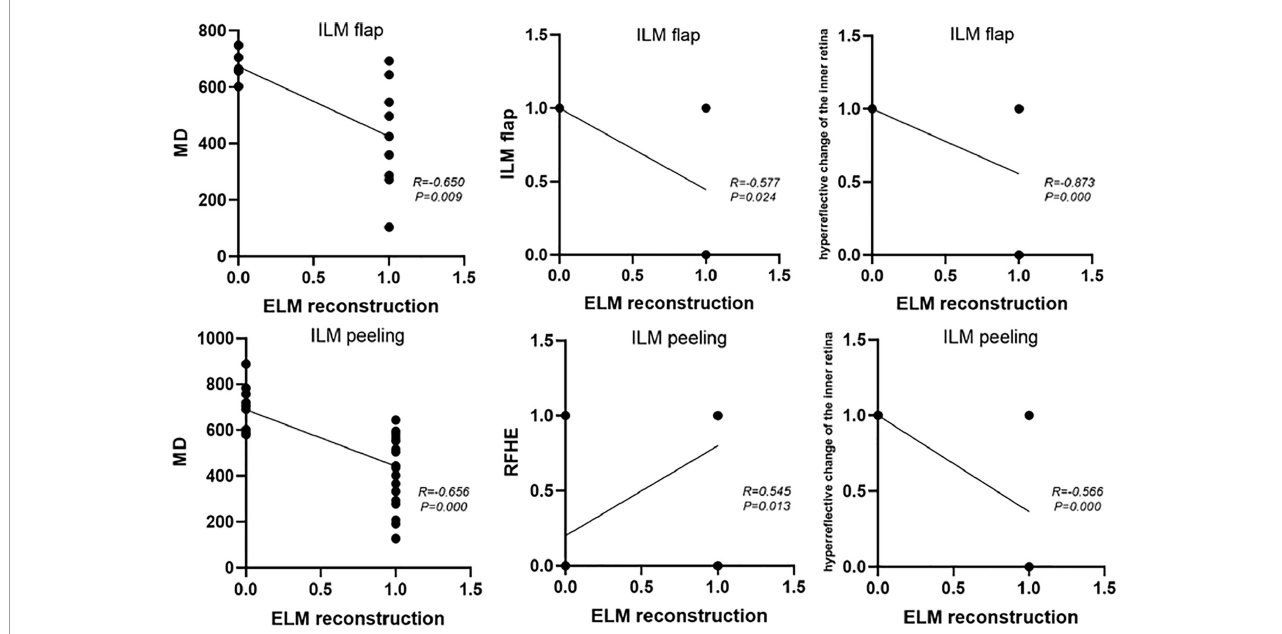
FIGURE4 The factors affecting postoperative ELM reconstruction in the flap group and the peeling group.